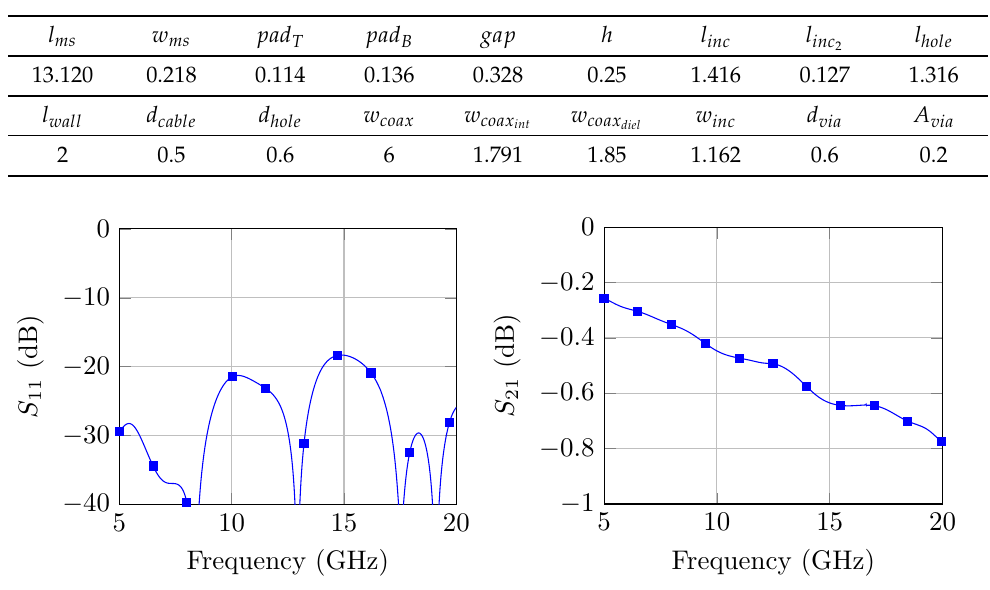
Table 1. Values of the parameters (mm) for the back-to-back prototype combining Taconic-RF (microstrip layer) and Rogers 4003C (rest).